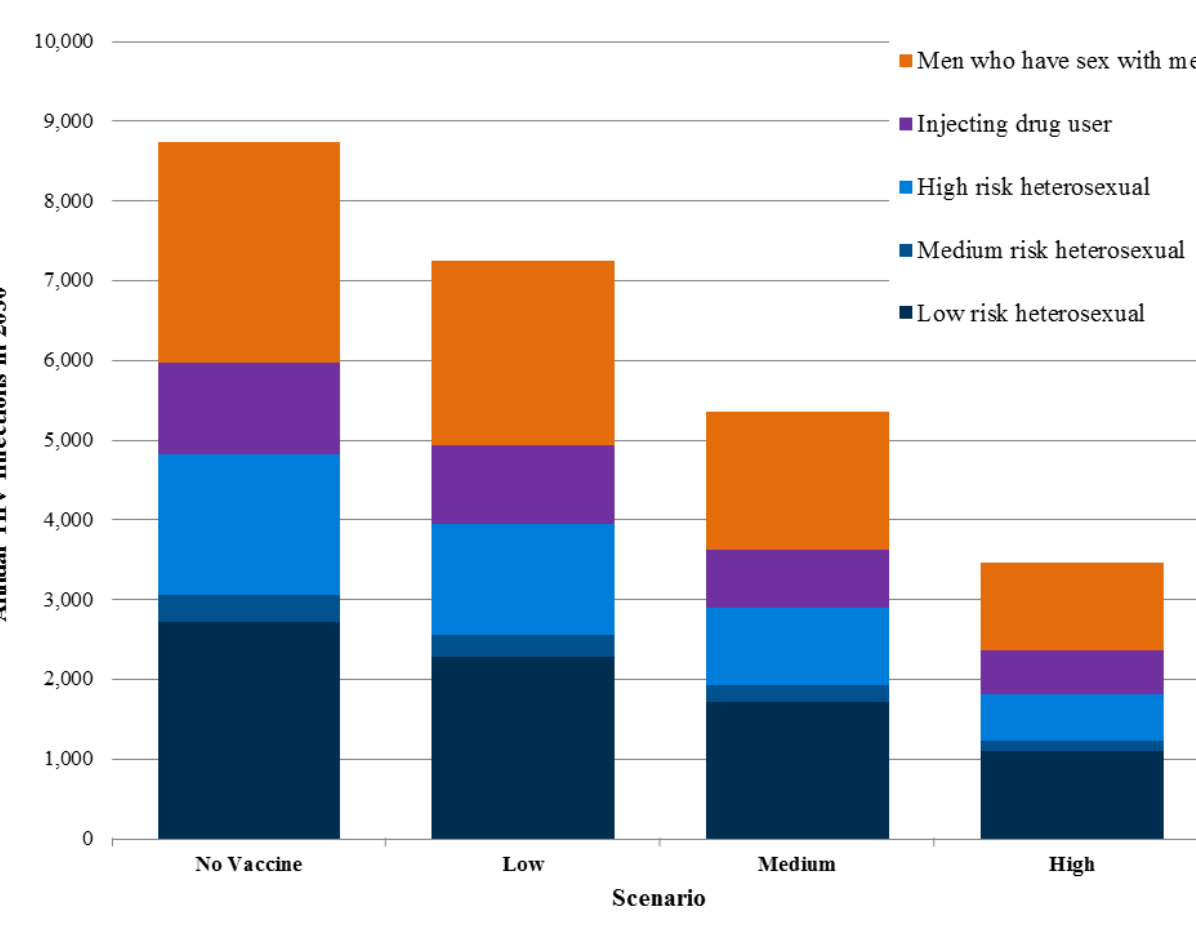
Figure 4. New adult HIV infections in Sichuan province by risk groups in 2030. Table 4. Potential vaccine strategies with a medium (50%) efficacy